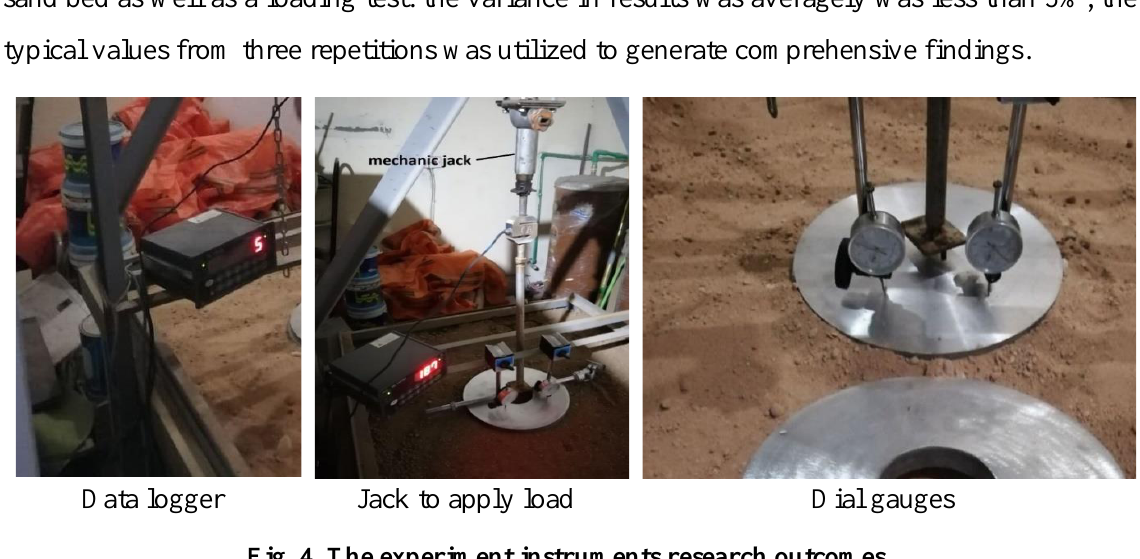
Fig. 4. The experiment instruments research outcomes.